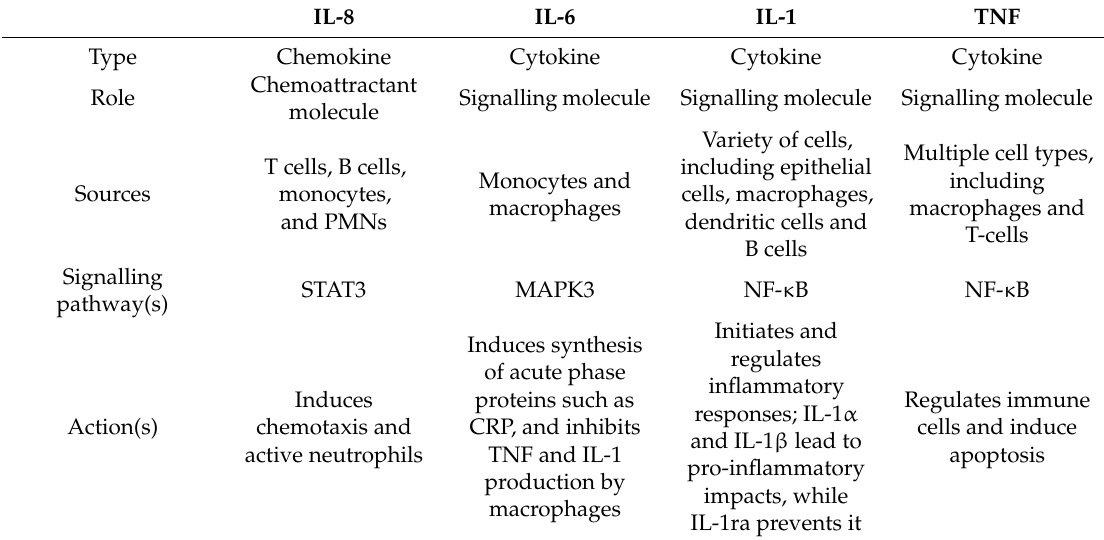
Table 2. A summary comparing the most common biomarkers in TMDs